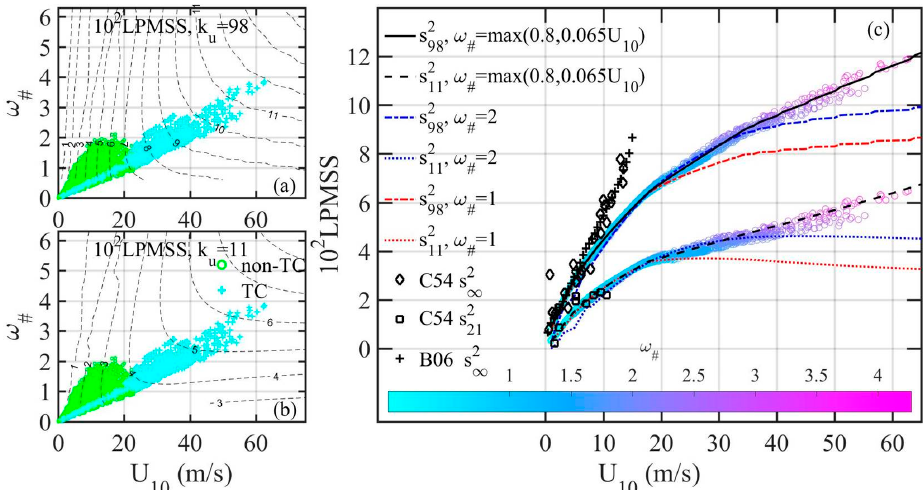
Figure 7. Pre-calculated H18 LPMSS contour maps for ( a ) k u = 98 rad/m and ( b ) k u = 11 rad/m. Superimposed in the Figures are the observed ω # ( U 10 ) in TC and non-TC conditions. ( c ) Color markers show the interpolated LPMSS for k u = 98 and 11 rad/m (upper and lower sets, respectively) using the observed ω # ( U 10 ) in TC and non-TC conditions. For comparison, illustrated with black markers are the optically sensed MSS in clean and slick waters. Also shown in the Figure are the interpolated LPMSS assuming constant ω # (1 and 2), and ω # approximated by Equation (16). s and 2 s are presented with color markers in Figure 8. For The interpolated H18 2 98 11